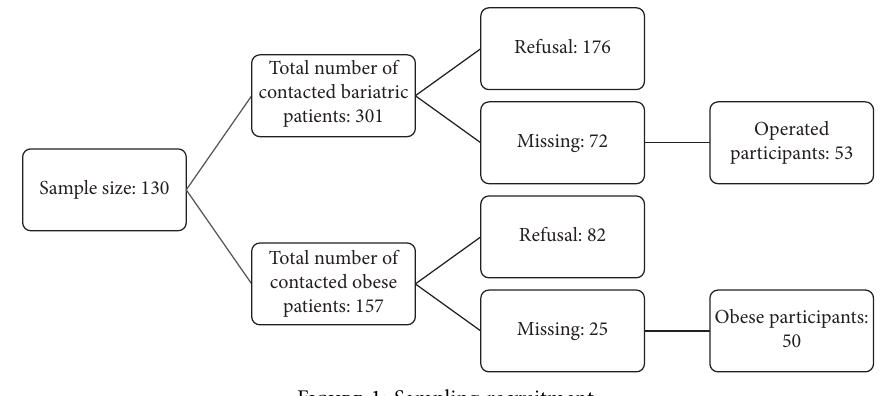
Figure 1: Sampling recruitment.